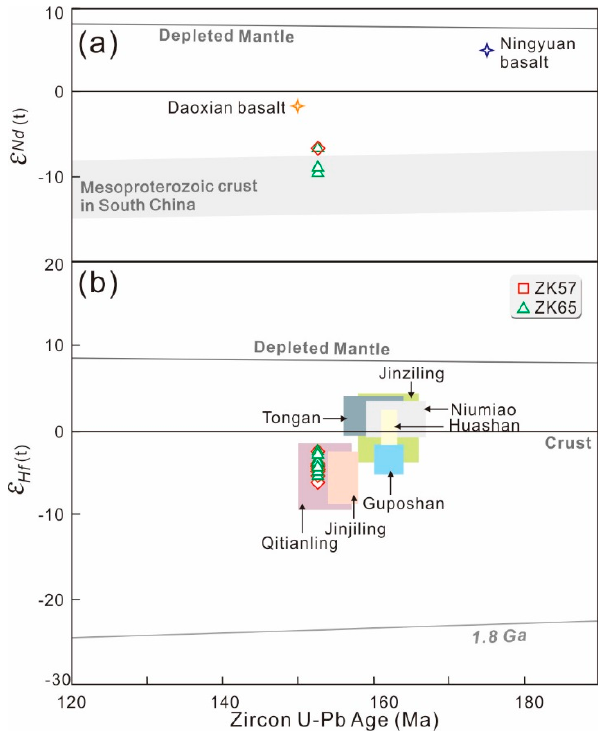
Figure 7. ( a ) ε Nd (t)-age diagram and ( b ) ε Hf (t)-age diagram for zircons from Xianghualing area. The